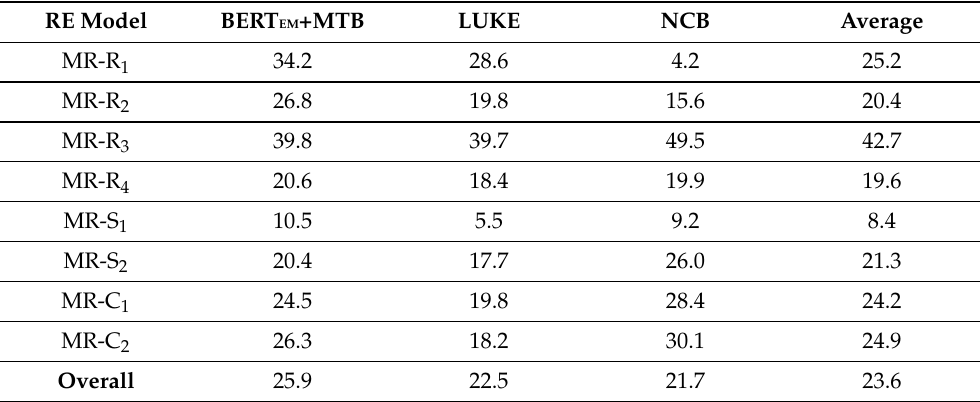
Table 6. Violation rates (%) of RE models for different MRs.